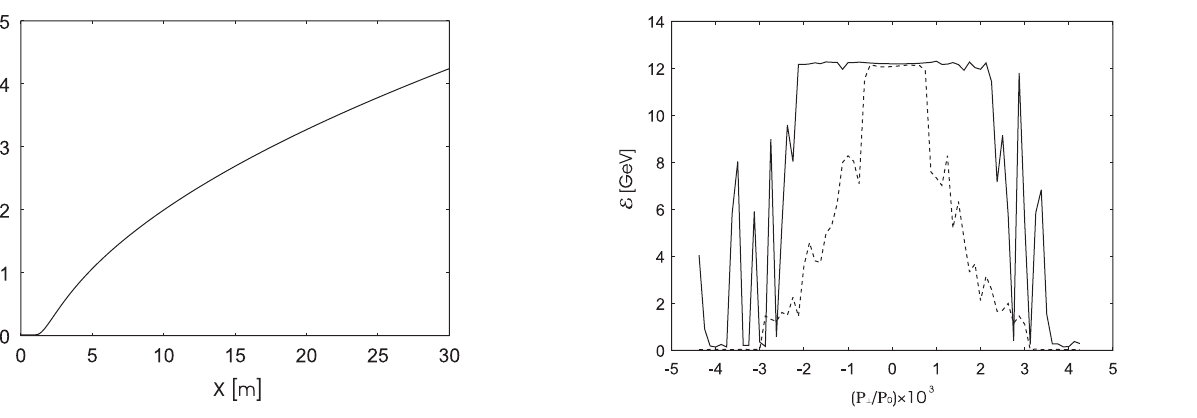
FIG. 9. The final energy versus initial transversal momentum p ? for the same interaction parameters as in Fig. 6. The solid line corresponds to a plane wave, while the dashed line corre- sponds to a focused nonplane laser